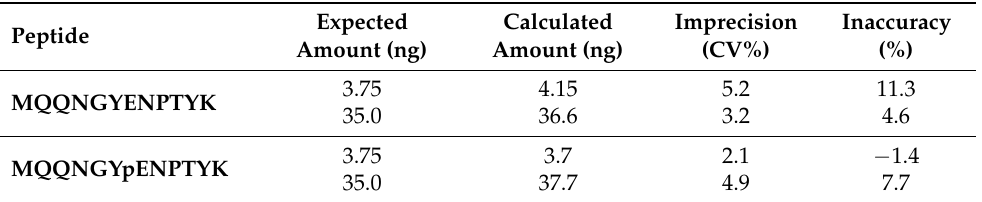
Table 3. Within-day imprecision (CV%) and inaccuracy (%) of results obtained by measuring two QC levels 6 times within one day ( n = 6).